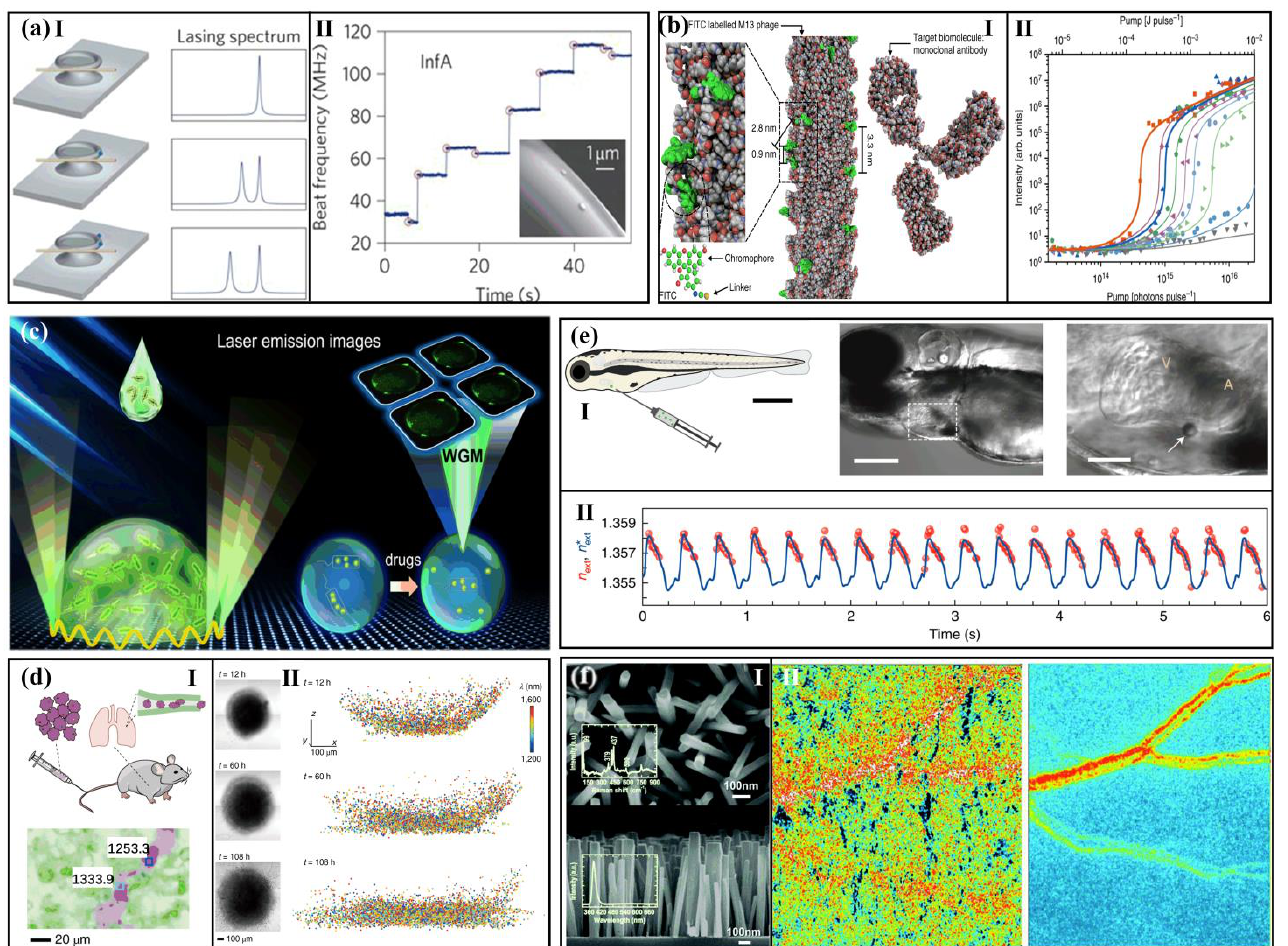
Figure 6. Monitoring the life activities of living organisms with biolasers. ( a ) Ⅰ : Diagrams presenting how the lasing spectra change as one and two nanoparticles (blue spheres) are connected to the microcavity. Ⅱ : Discrete variation in beat frequency with time when influenza A virions are bound to a WGM microlaser. Red circles represent single virus binding situations. Inset: Two InfA virions on the microlaser captured by scanning electron micrograph. (Adapted with permission from [91].